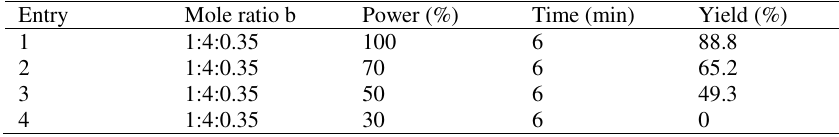
Table 7 Change the power of microwave